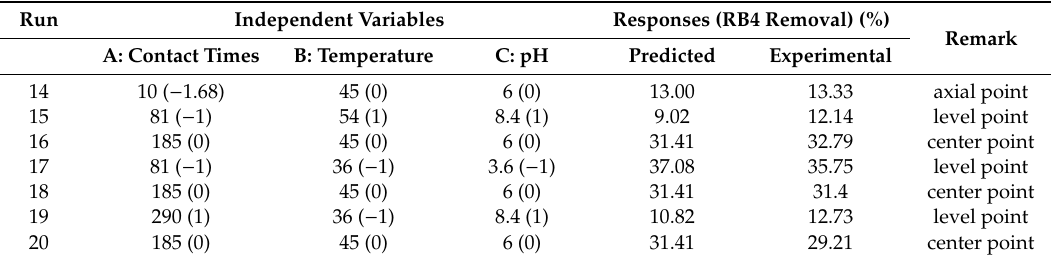
653 Figure 3. FTIR spectra of the rice bran, rice bran/SnO 2 , and rice bran/SnO 2 /Fe 3 O 4 . 414-100 100-62 62-18 18-15 15-9.4 9.4-8.0 8.0-6.4 6.4-5.2 5.2-1.8 1.8-1.70.0000.0450.0900.1350.180 P o re A re a ( m 2 / g ) Pore Diameter Range (nm)